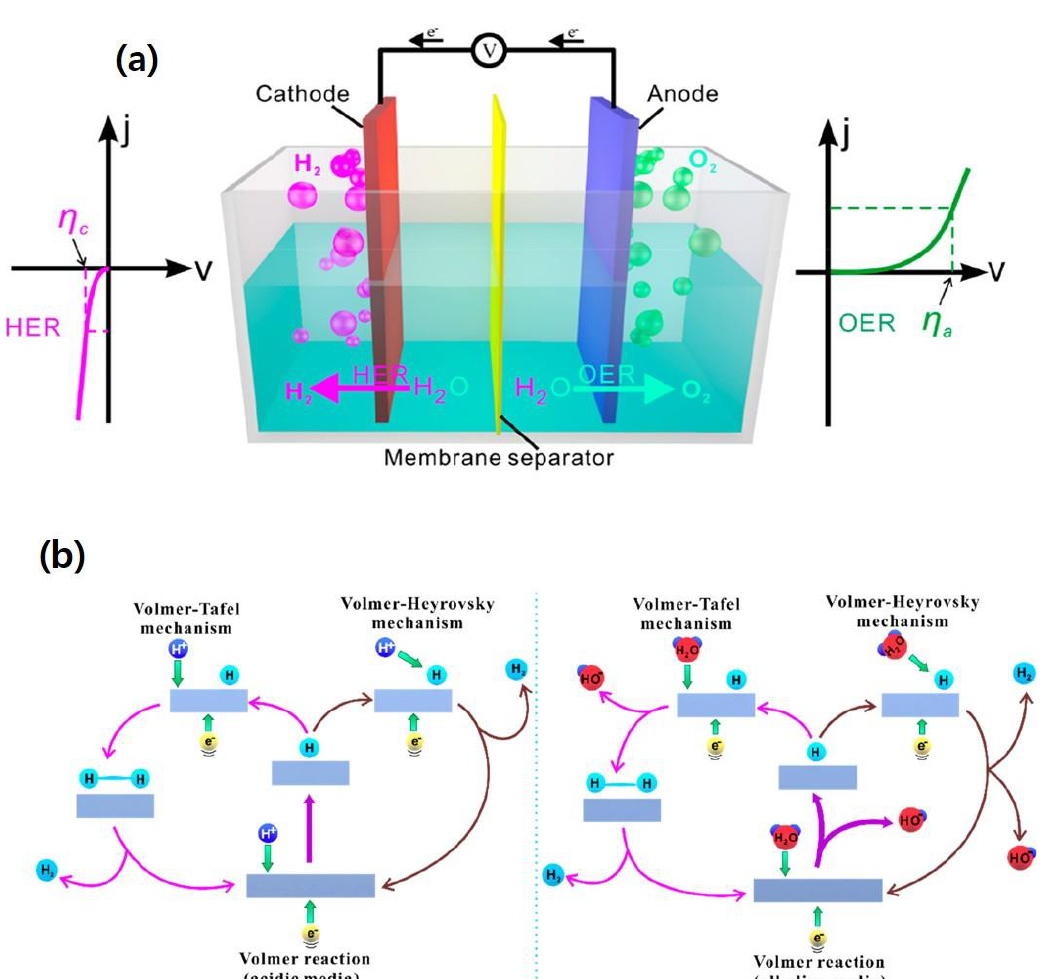
Figure 1. ( a ) Schematic mechanism of OER and HER processes during overall water-splitting process, ( b ) fundamental principles of HER over the surface of electrocatalysts in acidic and alkaline environments [23] . Copyright 2020 The American Chemical Society.